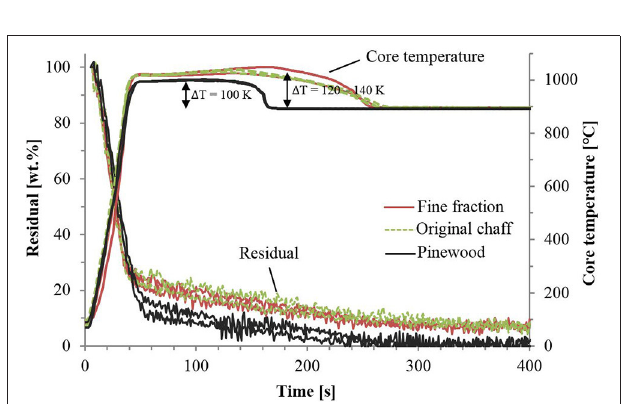
FIGURE 6 | Core temperature and residual of one pellet during the combustion at 900 ◦ C with ˙V tech.air = 10 L/min.